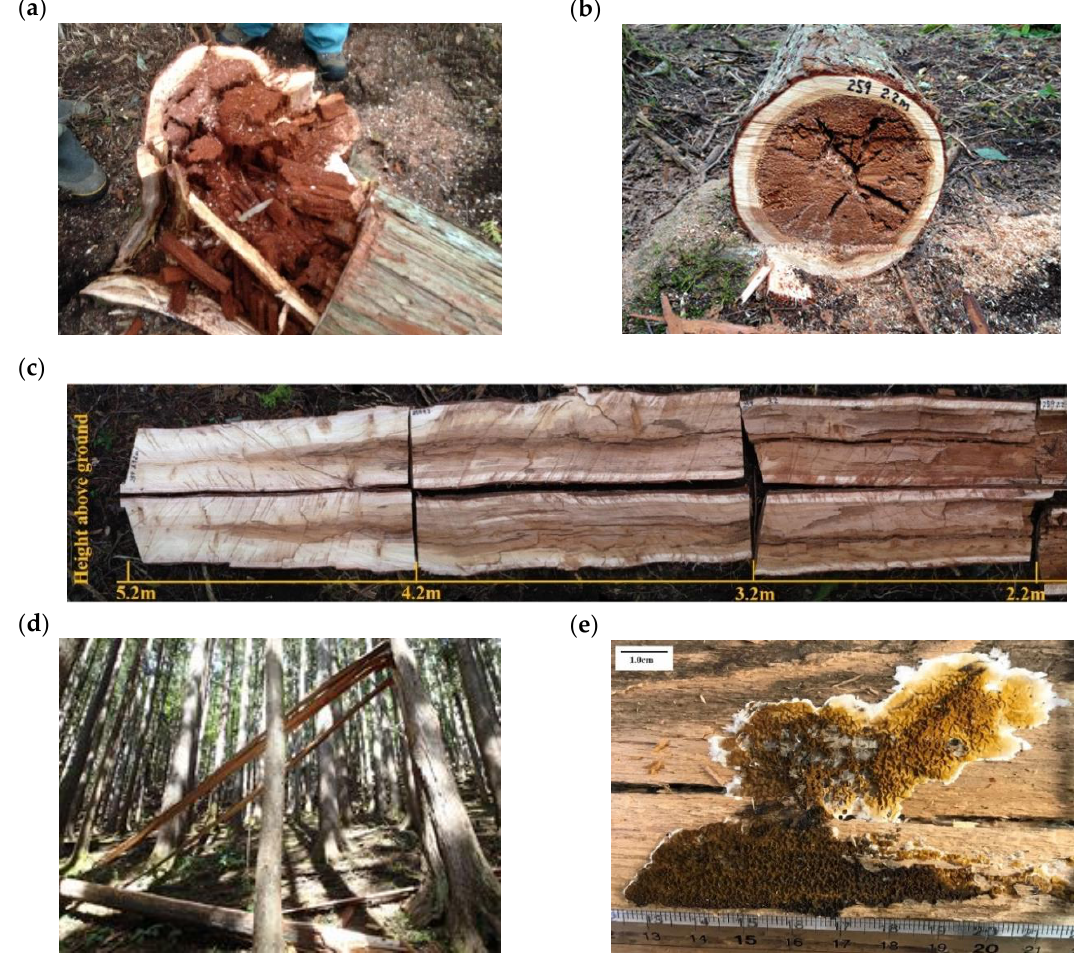
Figure 1. Serious butt rot caused by Serpula himantioides in living trees of Chamaecyparis pisifera in Japan: ( a ) Stump of a butt rot tree; ( b ) Transverse section of a decayed tree at 2.2 m height above ground. Brown rot was observed in most of the heartwood; ( c ) Longitudinal section of decayed wood from 2.2 m to 5.2 m above ground. The brownish area reached a height of 5.0 m above ground level; ( d ) Felling of trees caused by butt rot; ( e ) Fruiting body of Serpula himantioides .